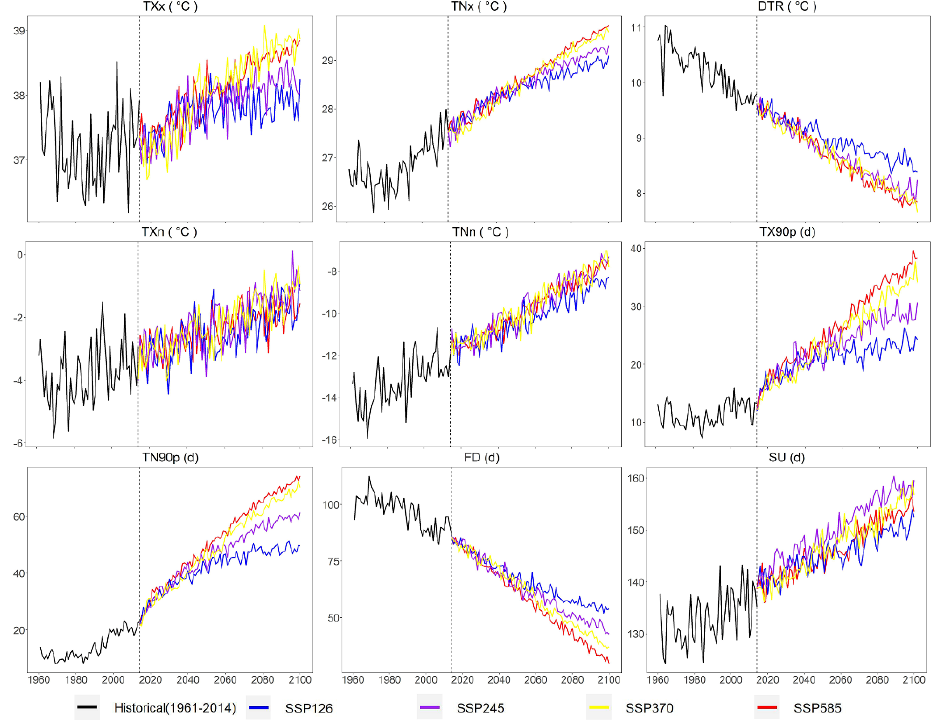
Figure 3. Trends in nine extreme temperature indices in the North China Plain under four future climate scenarios.